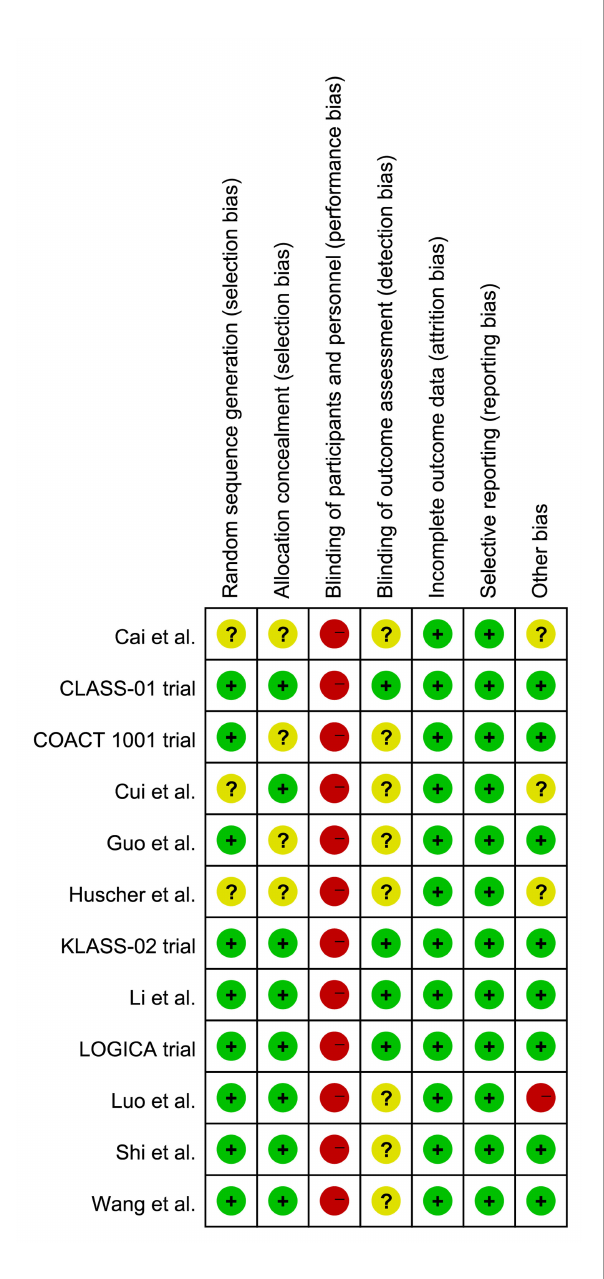
FIGURE 2 | Assessment of quality by the Cochrane risk of bias